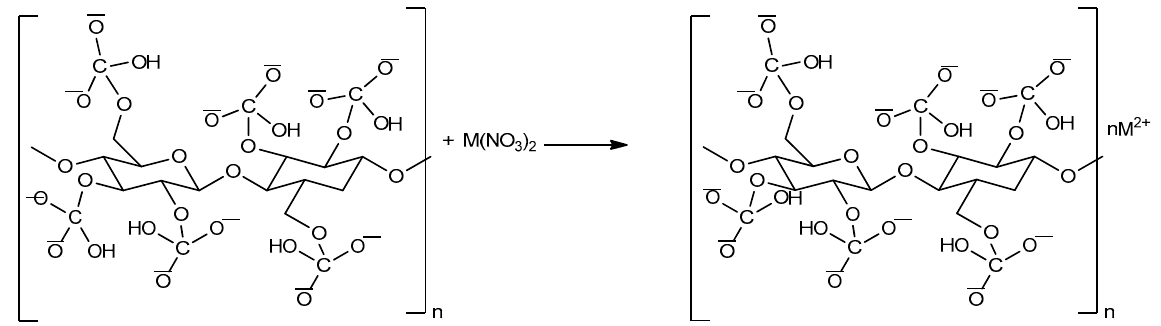
Figure 6. Proposed reaction scheme for the coagulation of Cu/Pb/Fe on to MCNC.